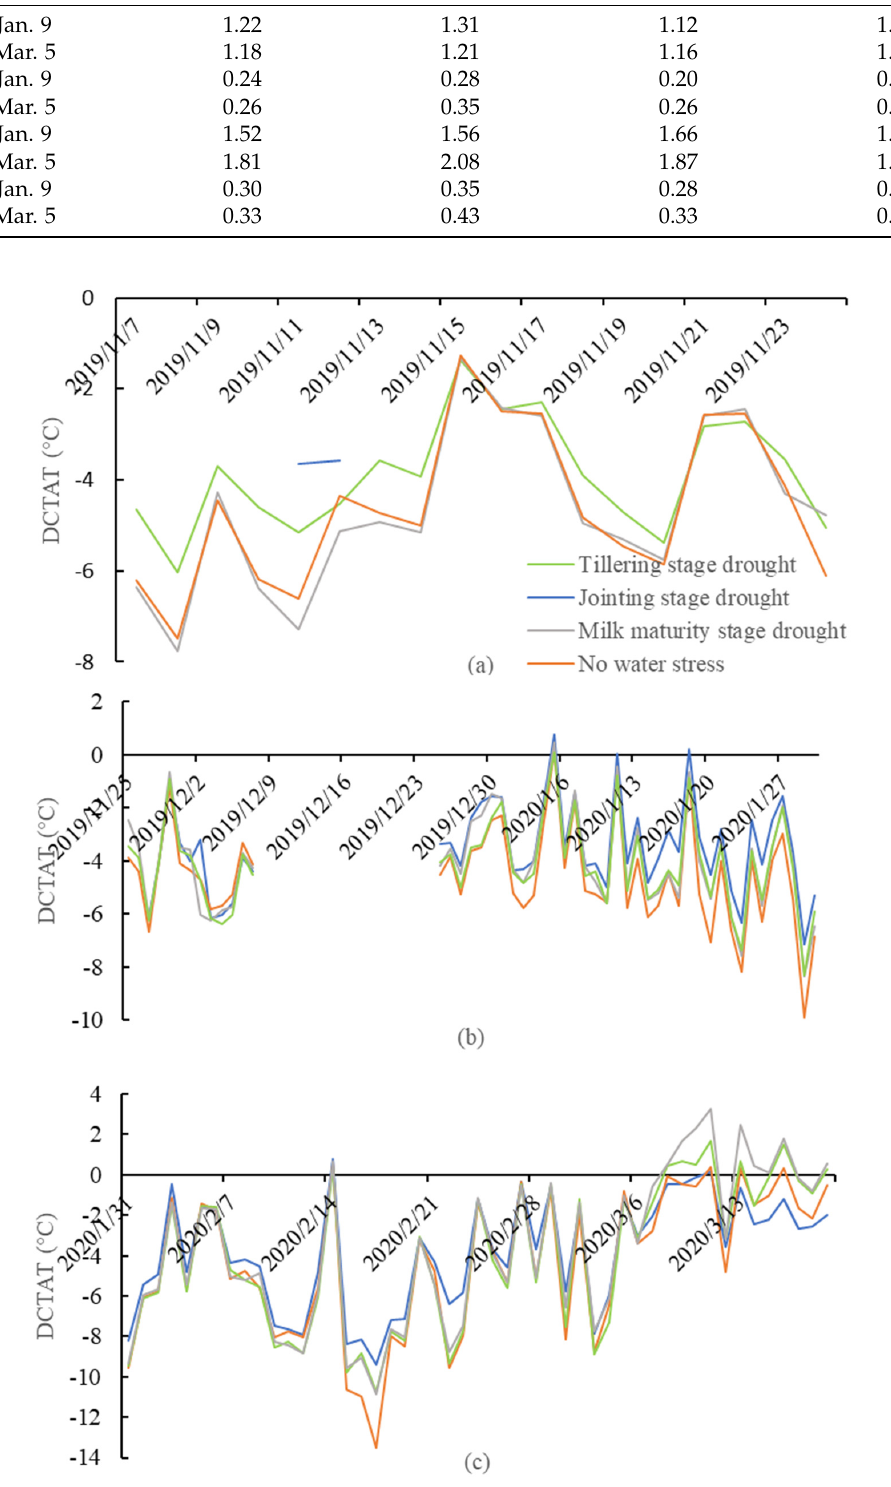
Figure 4. Difference between canopy temperature and ambient temperature (DCTAT). ( a – c ) repre- sent the tillering stage, jointing stage, and milk maturity stage, respectively. No data were attributed to sensor damage or equipment overhaul.(Date format: